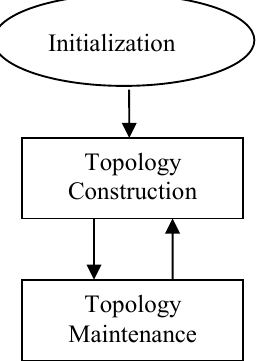
Fig. 2. The iterative execution of a topology control algorithm in a typical